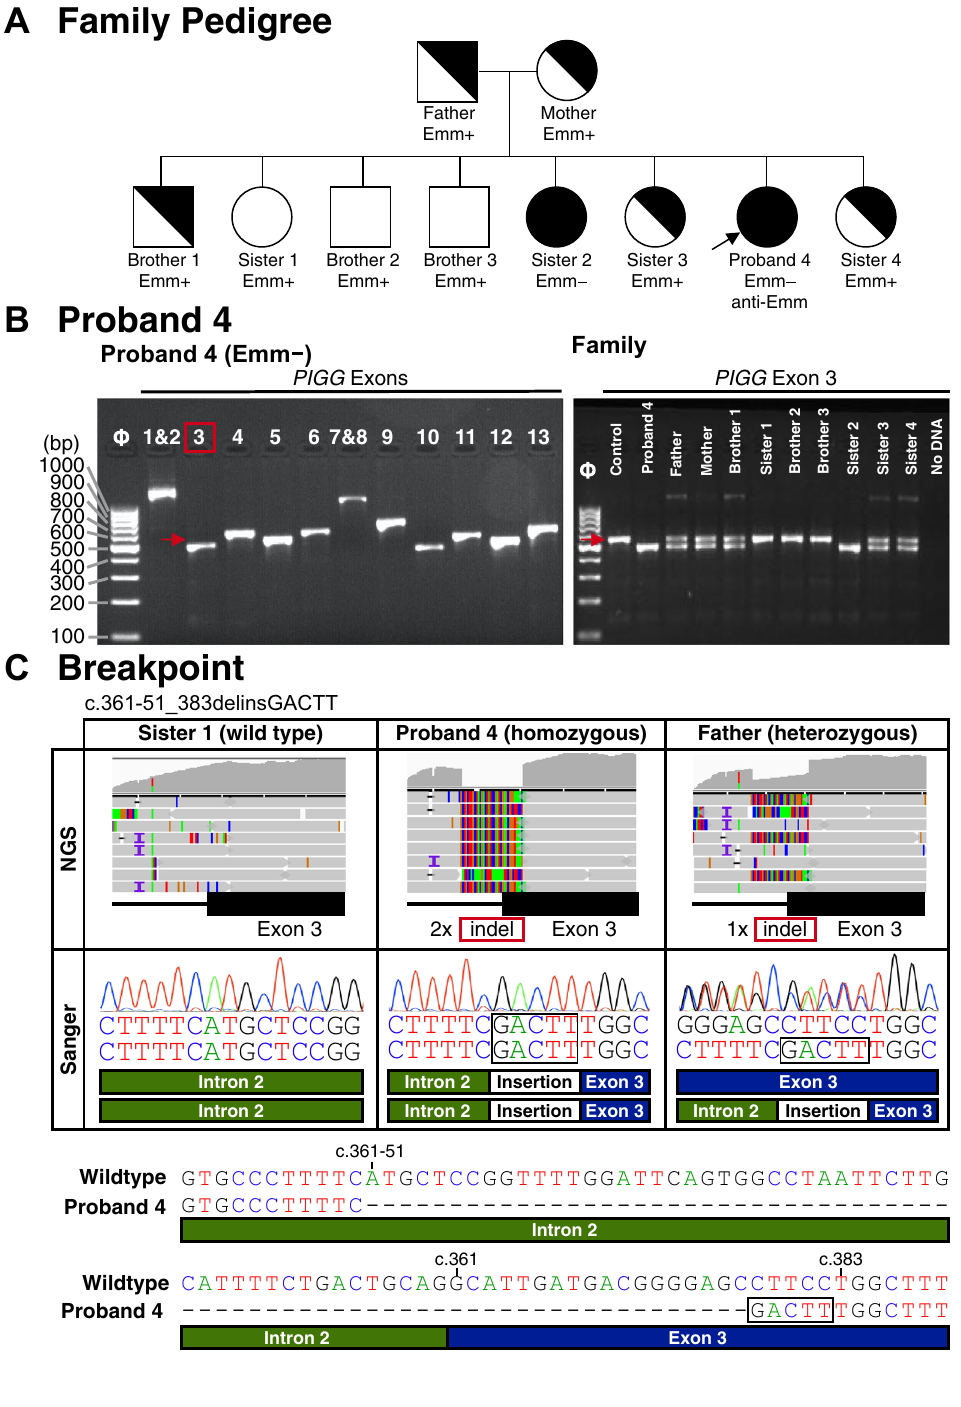
Figure 3. ( A ) Family Pedigree Proband 4. Emm RBC phenotypes shown include the North African Proband, who was pregnant with anti-Emm in the plasma, and her parents and 7 siblings. ( B ) Amplification of PIGG Exons 1 through 13. Amplified products covering the 13 Exons are shown. Arrow indicates the location of the Exon 3 product in the control sample. Exon 3 demonstrates ~ 100-bp deletion in the sample from Proband 4 compared to control. ( C ) Proband 4 deletion breakpoints. Amplification of Exon 3 in the sample from North African Proband 4 indicated an approximate insertion deletion (indel) in PIGG compared to the control (left). Targeted NGS indicated a breakpoint spanning the region of Intron 2 and Exon 3 compared (top). Analysis showed split reads containing the breakpoint sequencing spanning the deletion in Intron 2 and Exon 3 with 5 extra bases inserted near exon 3 (colored rectangles in alignment), c.361-51_383delinsGACTT, p.(Ala121_Pro128delinsAspPhe). Breakpoint was confirmed by Sanger sequencing (middle, note Sanger traces are reverse complemented since sequencing done using reverse primer). Deletion breakpoint sequence compared to wild type